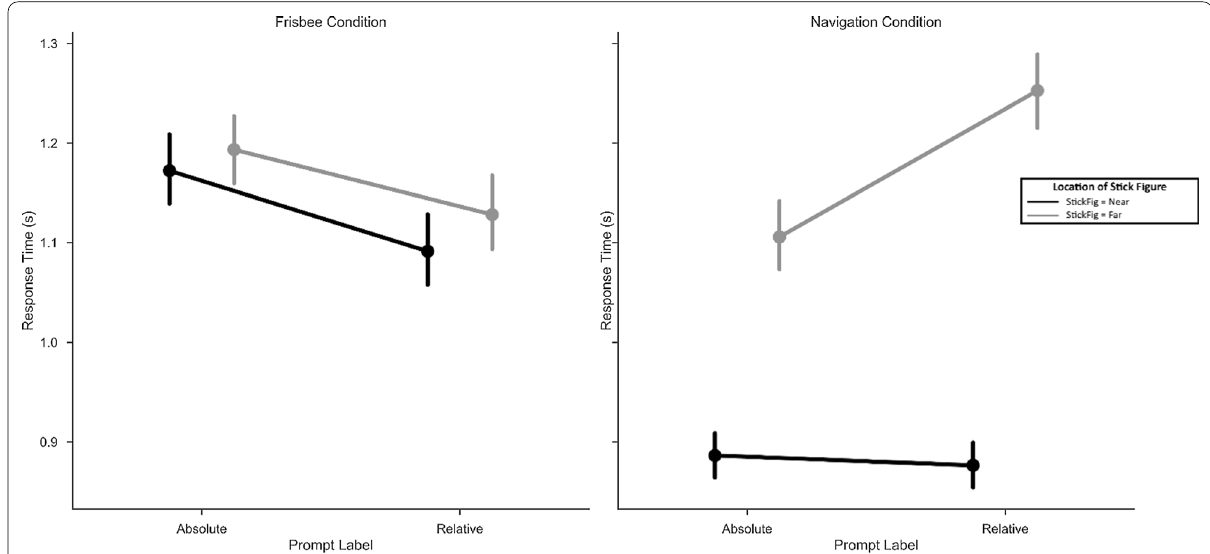
Fig. 8 Reaction times by condition and trial type (absolute or relative). A simplified version of Fig. 7, which shows both the differences across frisbee and navigation conditions as a function of stick figure location, as well as the interaction between stick figure location prompt type in the navigation condition. For the navigate condition, participants had slower reaction times for relative trials compared to absolute trials when the stick figure was on the far side of the display, but had similar (and faster overall) reaction times when the stick figure was on the near